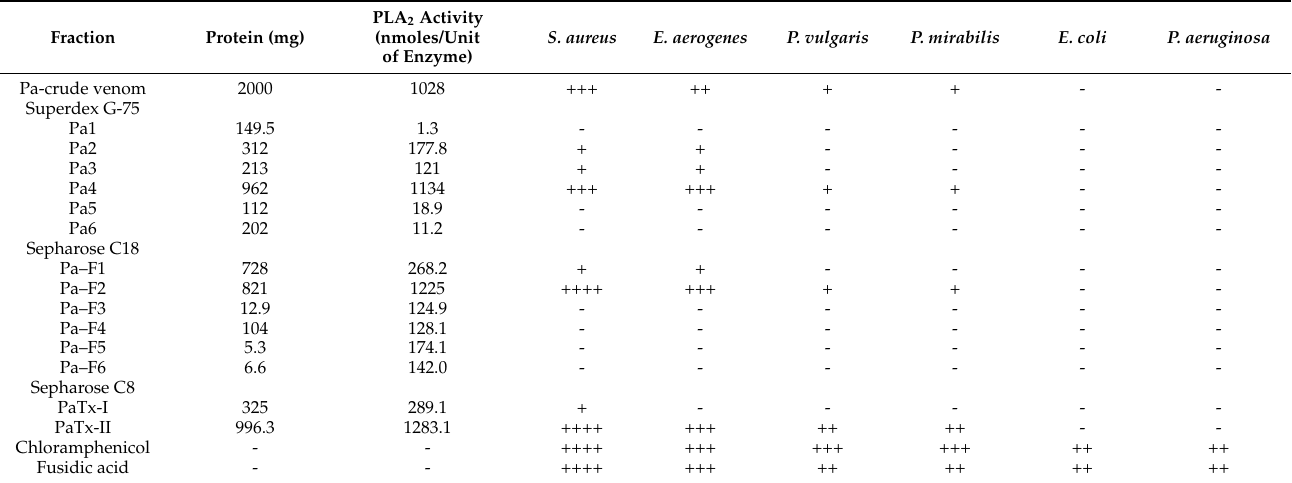
Table 1. Phopholipase A 2 (PLA 2 ) activities determined from the Pseudechis australis (king brown snake), in vitro bacterial screening of crude venom, purified fractions and proteins by standard procedures.